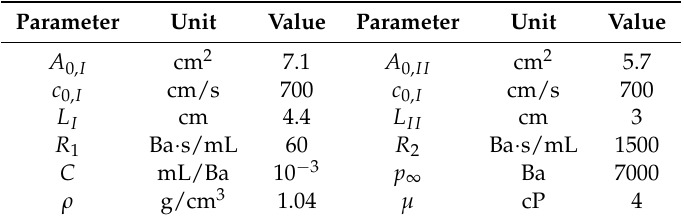
Table 3. Parameters of the 1D model of haemodynamics in the segments of the aorta. Parameter Unit